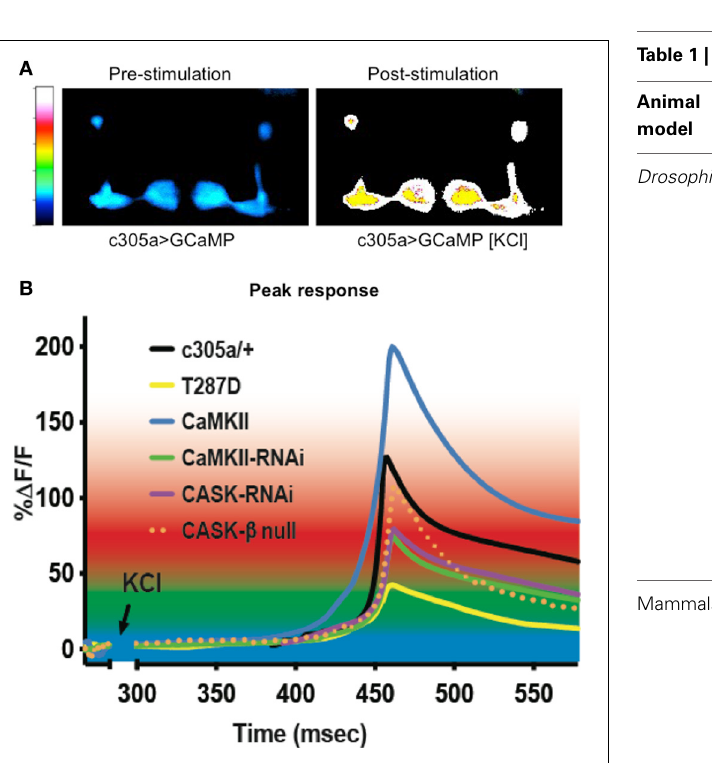
FIGURE 3 | CASK and CaMKII regulate dynamic changes in neural activity in mushroom body α ’/ß (cid:2) neurons. (A) Color coded images of a fly brain showing GCaMP fluorescence in the mushroom body α ’/ß (cid:2) lobes using c305a-Gal4 before and after application of depolarizing high [KCl]. (B) Traces showing averaged GCaMP fluorescence overtime in the α (cid:2) /ß (cid:2) lobes ( c305a-Gal4 ) co-expressing the different CASK and CaMKII transgenes or CASK- β null compared to the control c305a/ + expressing GCaMP (solid black line). GCaMP fluorescence is reduced in CASK- β null (dotted orange line) and when CASK-RNAi (purple line), CaMKII-RNAi (green line), or CaMKII-T287D (yellow line) were expressed in the α (cid:2) /ß (cid:2) neurons, while CaMKII overexpression (blue line) increased the maximum response compared to